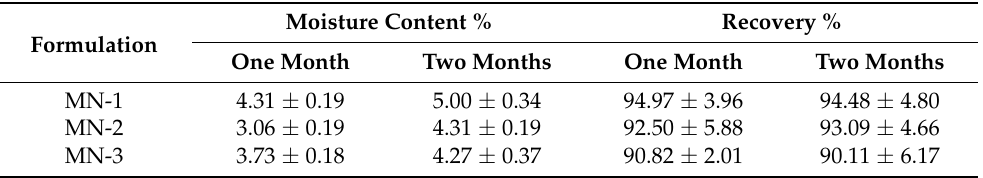
Table 8. Moisture content percentage and recovery percentage for MN-1, MN-2, and MN-3 after one and two months (Mean ± SD, n =